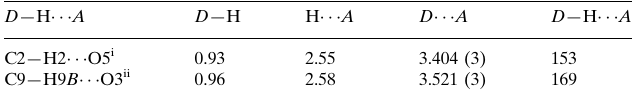
Hydrogen-bond geometry (A˚ , (cid:2)